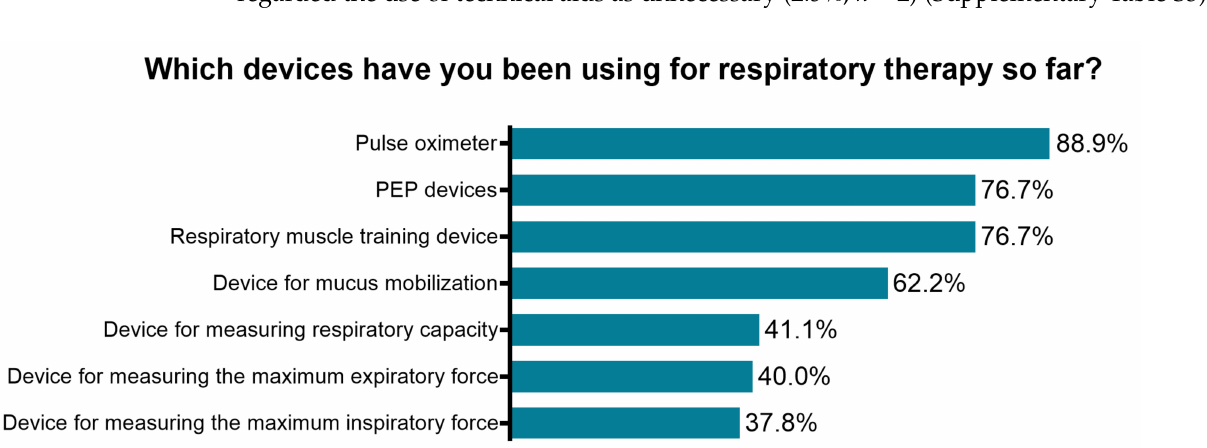
Figure 5. Assessment of the usage of respiratory rehabilitation devices/equipment among physiotherapists with previous experience in respiratory therapy ( n = 90). PEP, positive expiratory